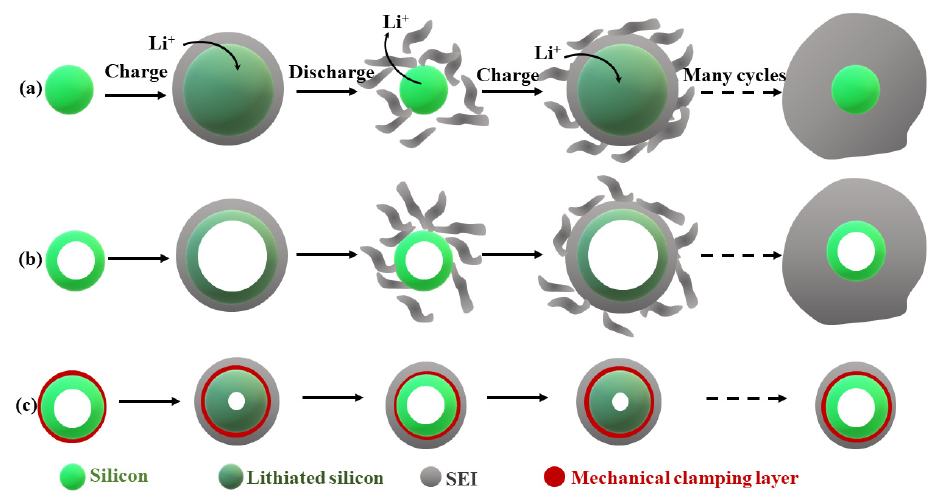
Figure 5. Si-based nanocomposites for anodes in LIBs and schematic of SEI formation on silicon surfaces: ( a ) solid silicon nanowire; ( b ) the silicon nanotube without a mechanical constraining layer; and, ( c ) designing a mechanical constraining layer on the hollow silicon nanotubes can prevent silicon from expanding outside toward the electrolyte during lithiation, based on [45].